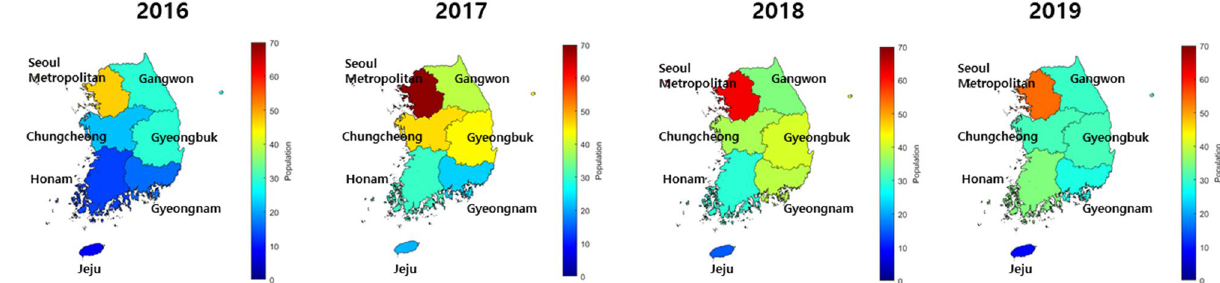
Figure 1. Distribution of the number of SFTS cases stratified by seven geographical areas from 2016 to 2019 in Korea. The map is simply drawn using MATLAB R2020b from GIS shape file (http:// www. gisde velop er. co.